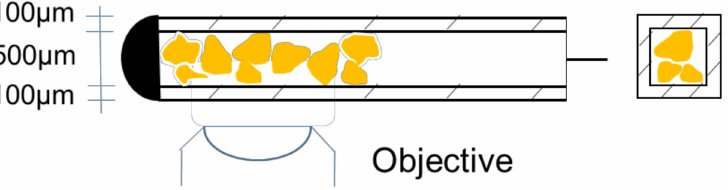
Figure 1. Experimental setup for optical microscopy runs. The cell, a thin glass capillary with a square cross-section, is inserted into a thermostated holder (not shown), on an inverted